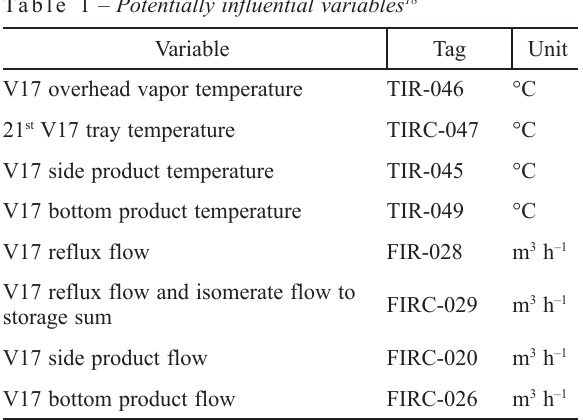
Table 1 – Potentially influential variables 18